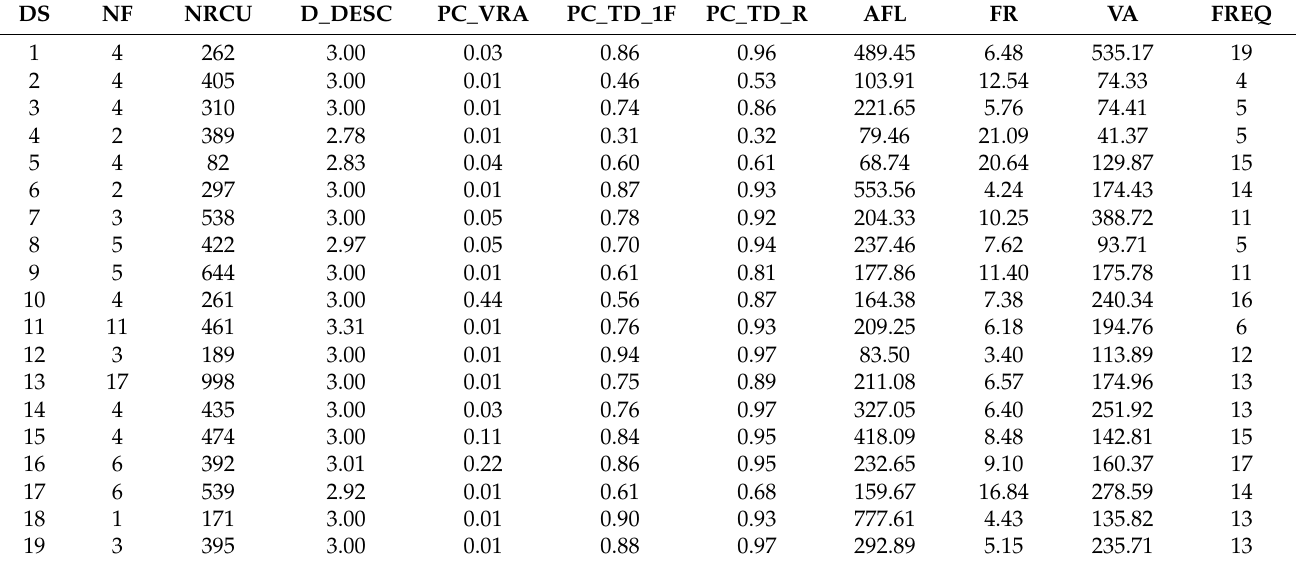
Table 4. Database (attributes and frequency of voltage